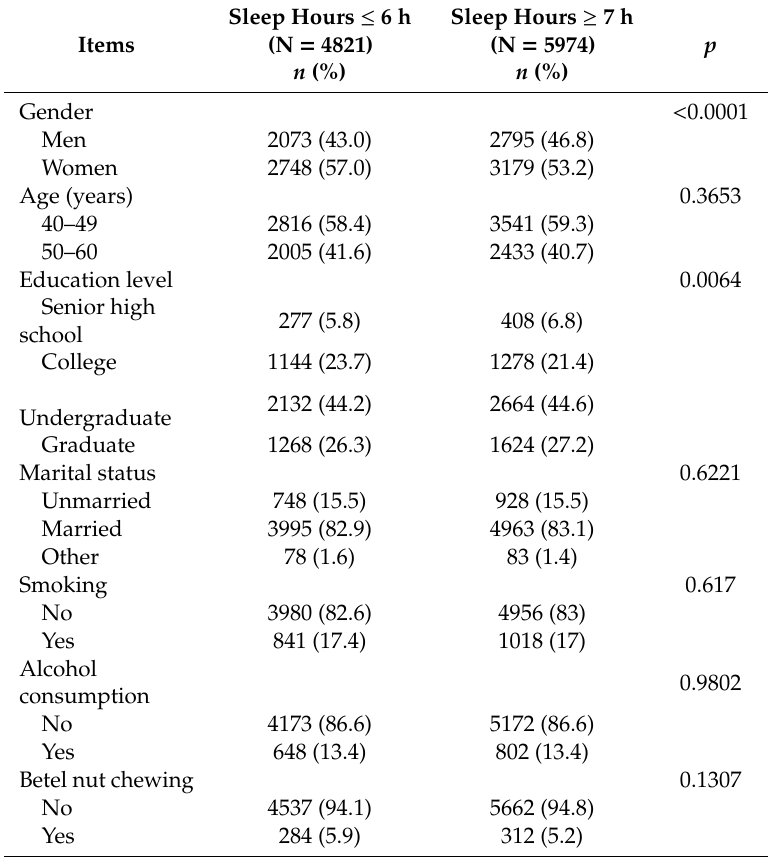
Table 1. Demographic information and two groups of sleep durations for workdays.